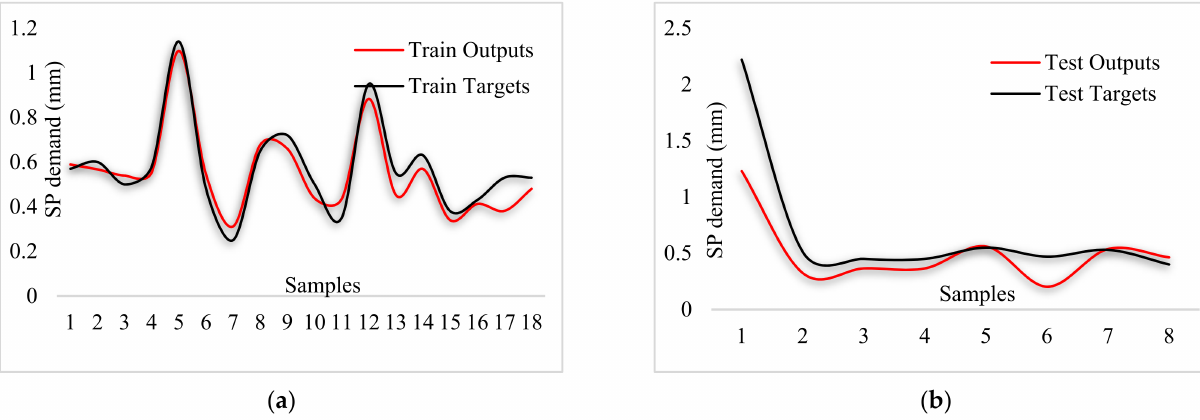
Figure 17. Comparison of outputs and targets for ANFIS-DEO: ( a ) Testing phase, ( b ) training phase.